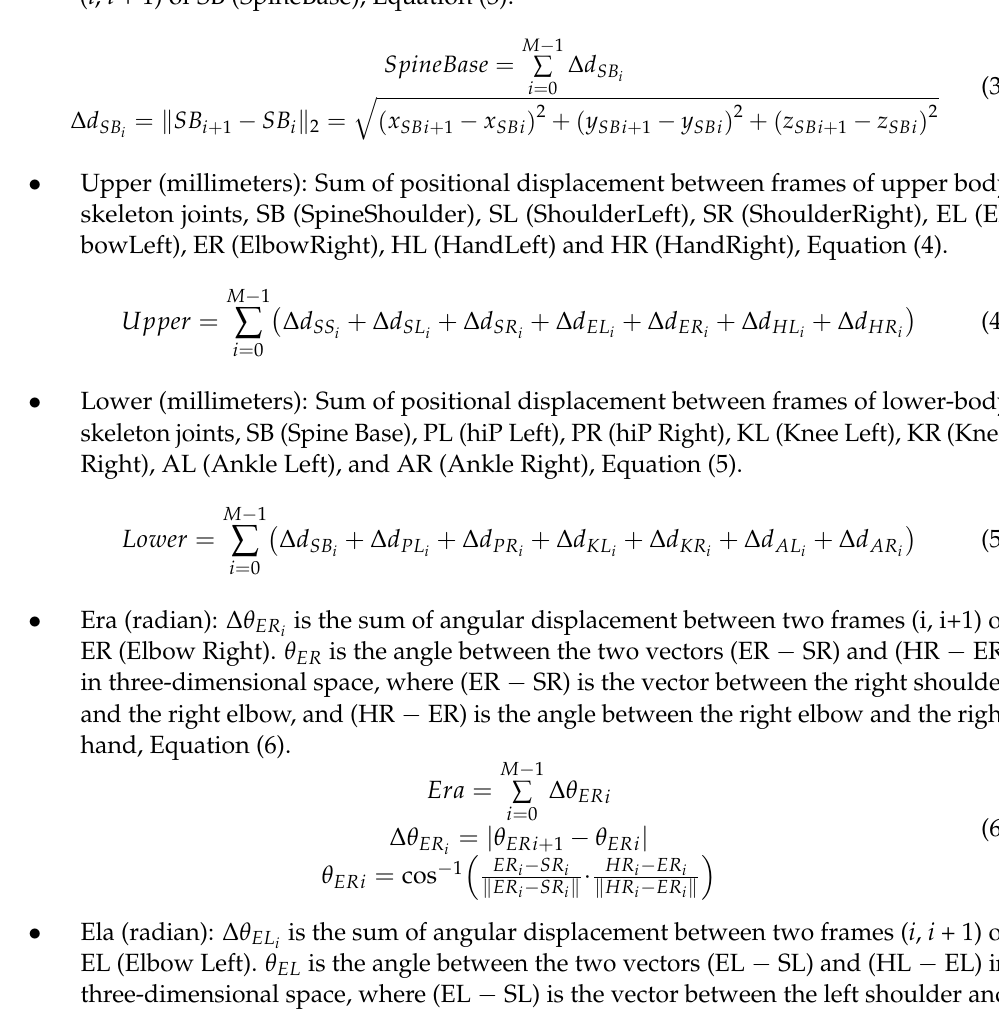
Figure 5. Average ECG and Kinect measurements of the subjects by exercise type (** p -value < 0.01 *** p -value < 0.001).